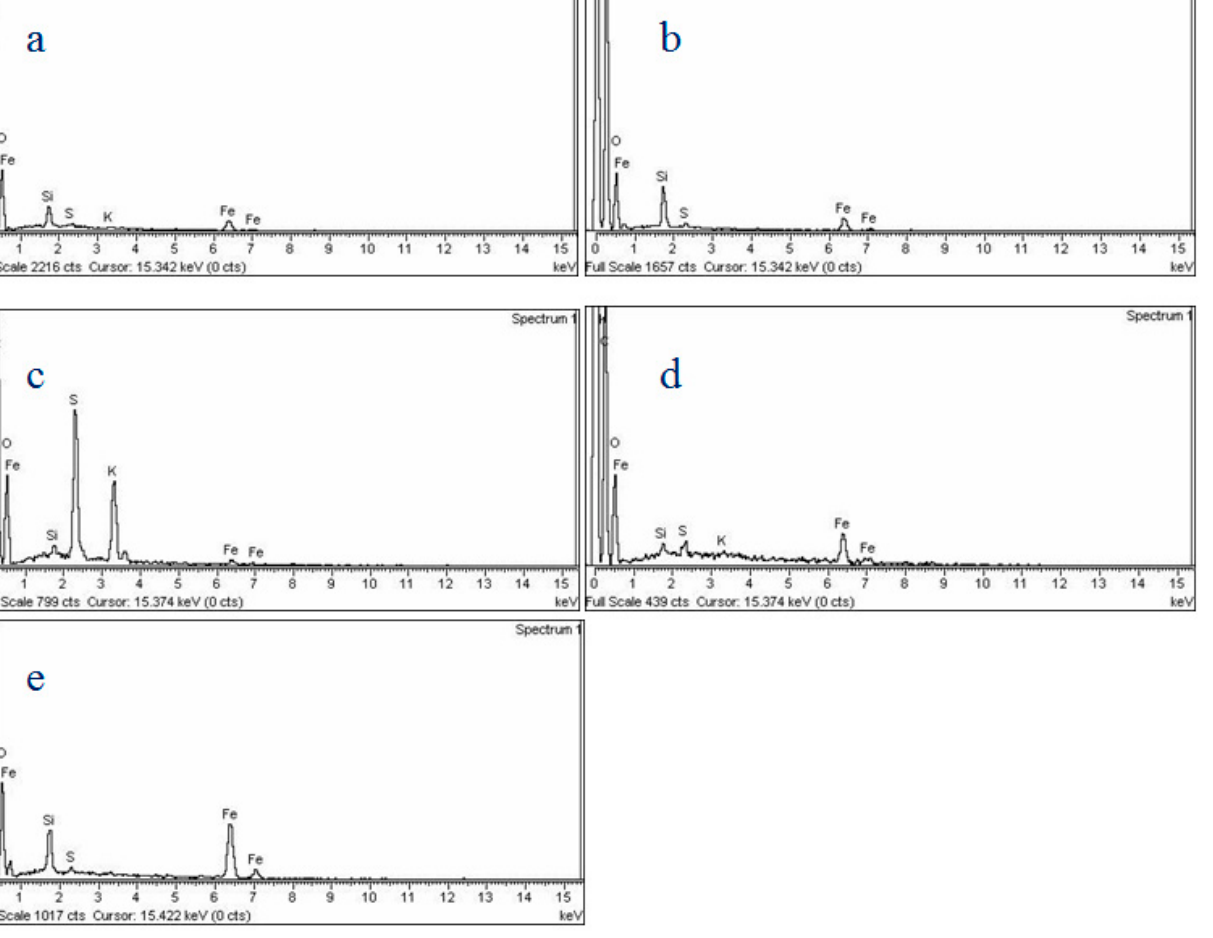
Figure 7. EDX analysis of